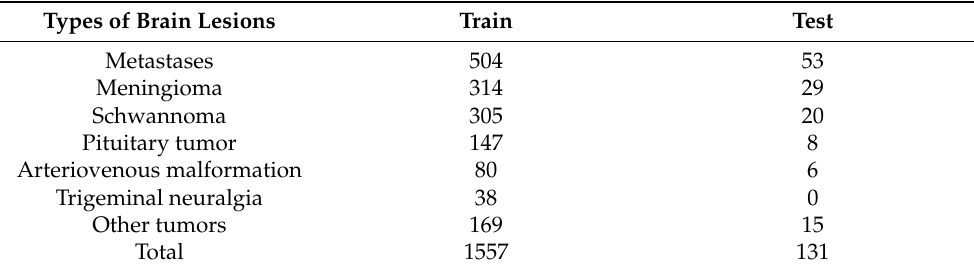
Table 1. Clinical diagnoses of 1688 patients in the final